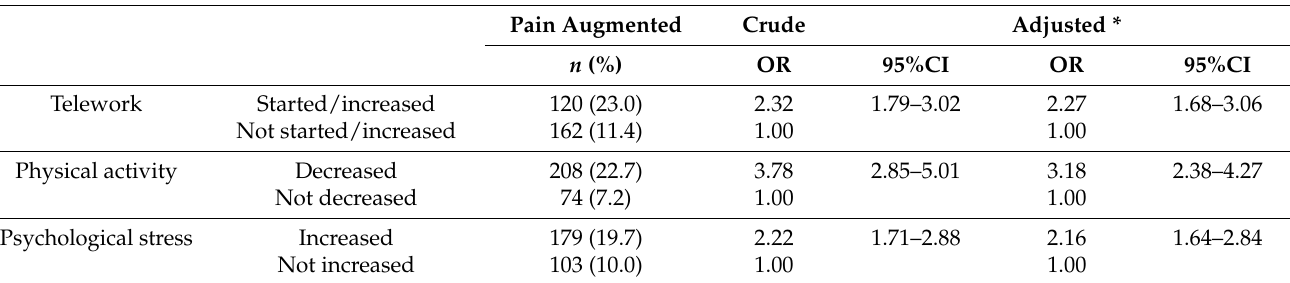
Table 2. Association of pain augmentation with telework, physical activity, and psychological stress since the start of the COVID-19